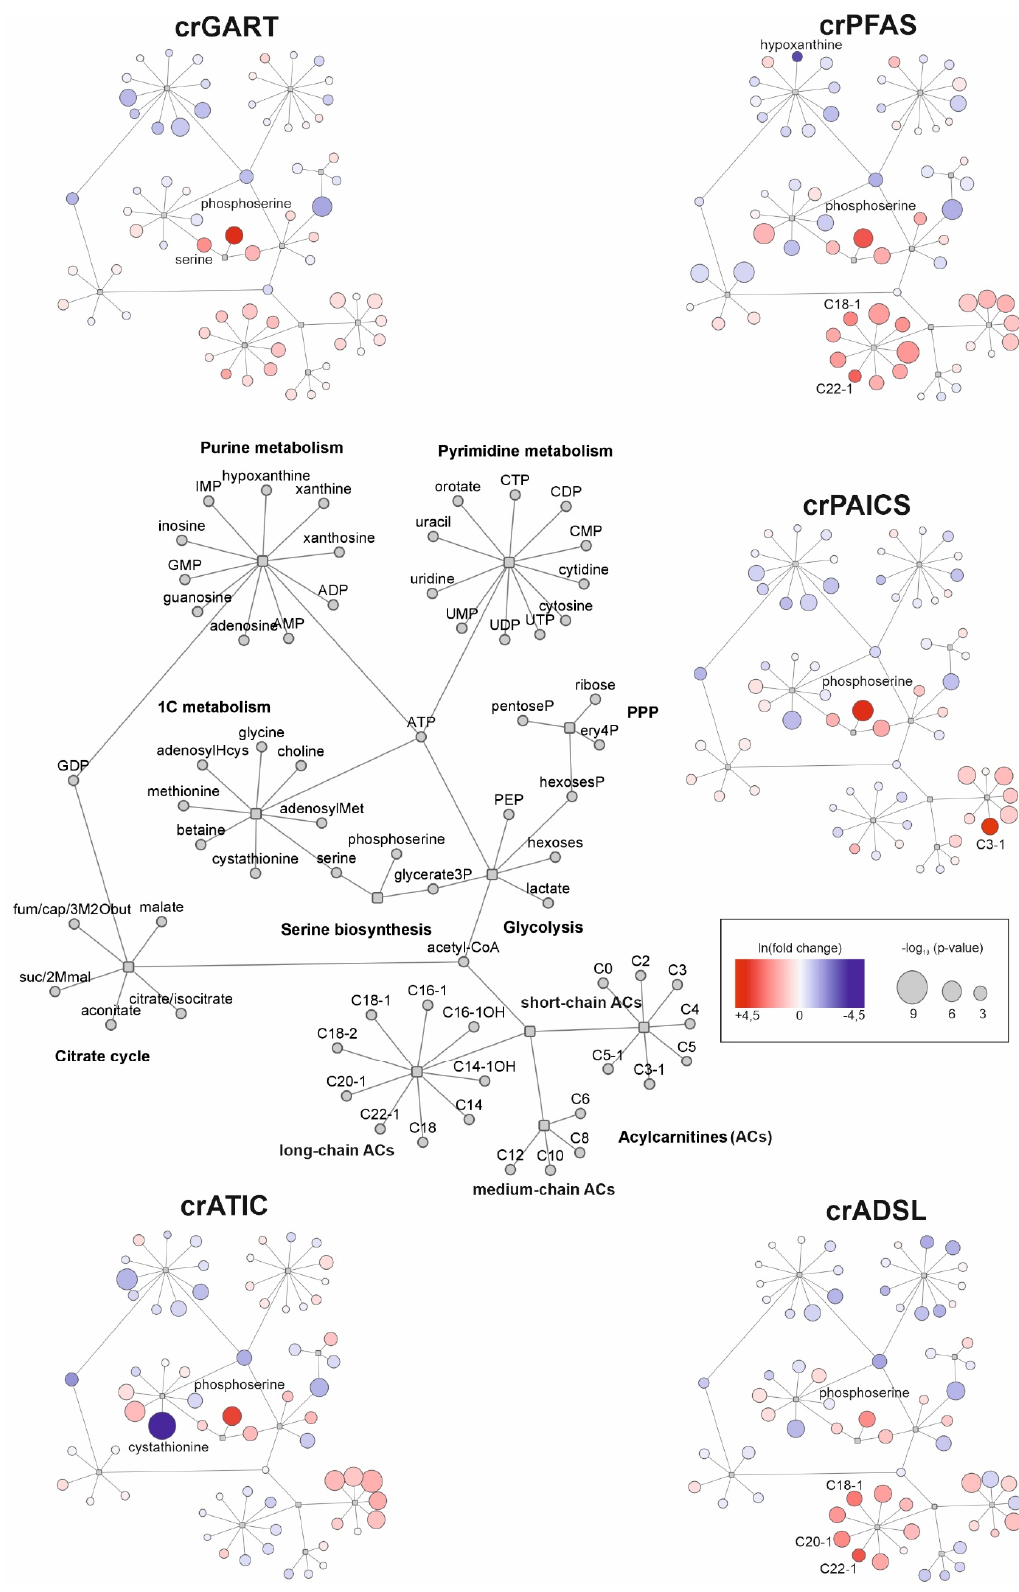
Figure 4. Visualization of the changes detected in cellular metabolism of PDNS-deficient cells compared to control cells performed in Cytoscape software. The general metabolite network of affected